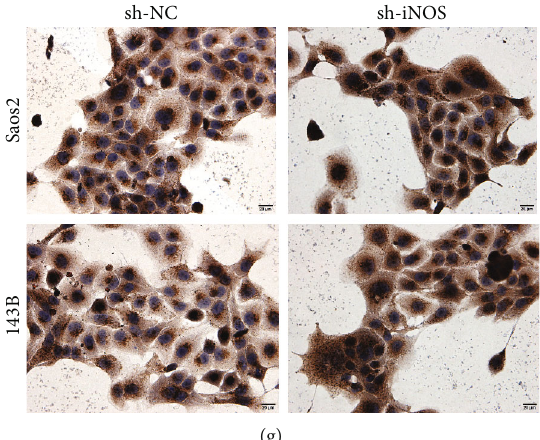
Figure 4: iNOS promotes OS tumor growth. (a) Tumorigenesis in nude mice inoculated with sh-NC and sh-iNOS. (b) The tumor volume change in nude mice ( ∗ p < 0 : 05 ). (c) The tumor weight change in nude mice ( ∗ p < 0 : 05 ). (d) The relative iNOS expression in tumor in mice transplanted with sh-NC and sh-iNOS ( ∗ p < 0 : 05 ). (e) The β -catenin expressions in nude mice transplanted with OS cells treated with sh-iNOS. (f) IHC assay detected the iNOS in tissues collected from OS mice. (g) IHC assay detected the β -catenin in tissues collected from OS